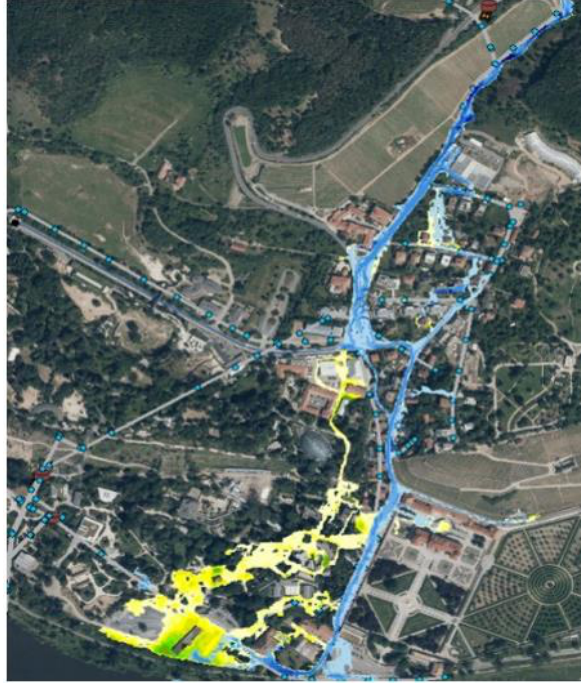
Figure 11. Original (yellow) and final flood extent for proposed